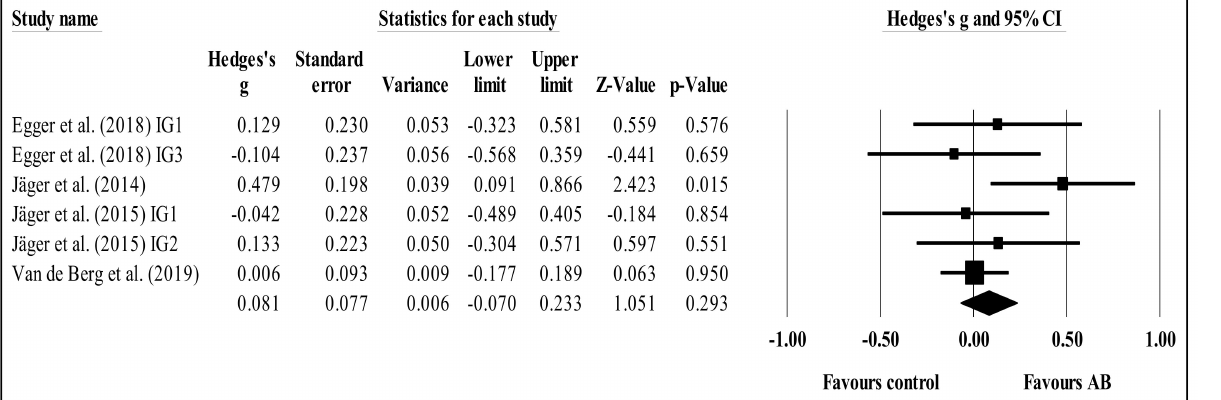
Figure 2. Forest plot of changes in inhibition in school-age students participating in active breaks (AB) compared to controls. Values shown are effect sizes (Hedges’ g) with 95% confidence intervals (CI). The size of the plotted squares reflects the statistical weight of each study. The black diamond reflects the overall result. This trend is not statistically significant. IG: intervention